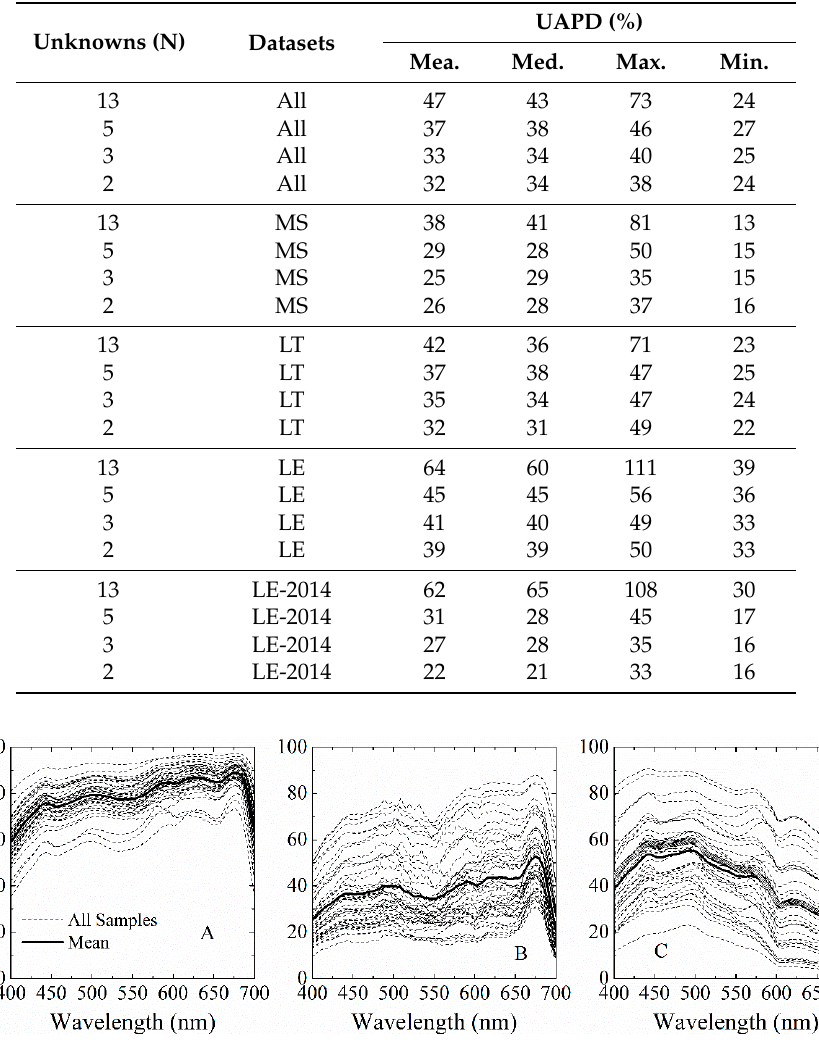
Table 3. The mean (Mea.), median (Med.), maximum (Max.) and Minimum (Min.) UAPD of different dataset with different number of unknowns (N) to be retrieved from MuPI.